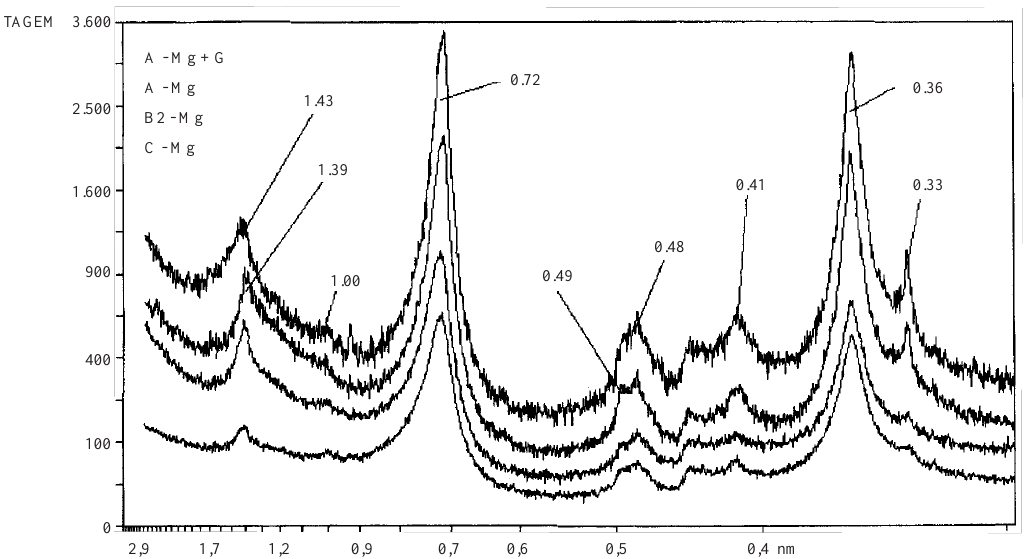
Figura 2. Difratogramas da fração argila orientada de amostras dos horizontes A, B2 e C do perfil P1, tratadas com magnésio (Mg) e magnésio após a adição de glicerol (Mg + G).